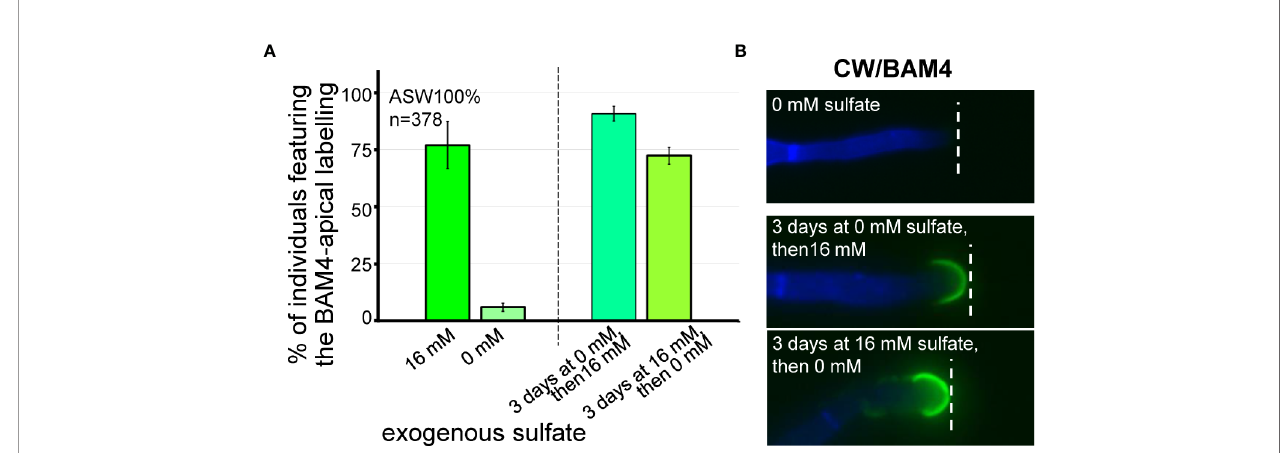
FIGURE 6 | Impact of sulfate depletion on the BAM4-fucan detection in apical cells. All the E. subulatus fi laments were observed after 15 days of culture in a medium based on 100% ASW but featuring different sulfate concentrations. (A) Histogram showing the proportion of labeled apical cells in the different culture conditions. The strong BAM4 labeling observed in normal ASW (16 mM sulfate) was not observed in a sulfate-depleted medium (0 mM sulfate) but it was recovered when the individuals were placed back in normal ASW after 3 days of culture without sulfate (i.e., 3 days at 0 mM sulfate followed by 12 days at 16 mM sulfate). Depleting the exogenous sulfate after 3 days of culture was of little impact on the BAM4 detection (i.e., 3 days at 16 mM sulfate followed by 12 days at 0 mM sulfate). (B) Micrographs showing the absence of BAM4-detection in apical cells of E. subulatus cultivated in a sulfate-deprived medium (0 mM sulfate) and its recovering upon sulfate addition after 3 days of culture (i.e., 3 days at 0 mM sulfate followed by 12 days at 16 mM sulfate). When E. subulatus was fi rst grown in normal ASW prior to sulfate depletion (i.e., 3 days at 16 mM sulfate followed by 12 days at 0 mM sulfate), the BAM4 epitopes were still detected on apical